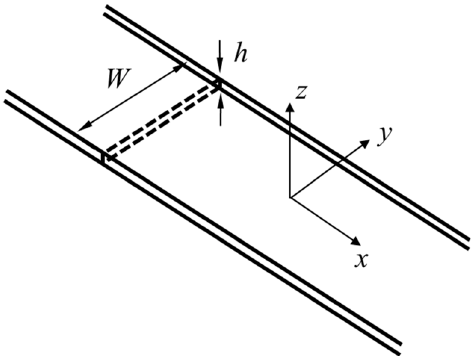
Figure 1. Coordinate system of a plate strip with finite width .